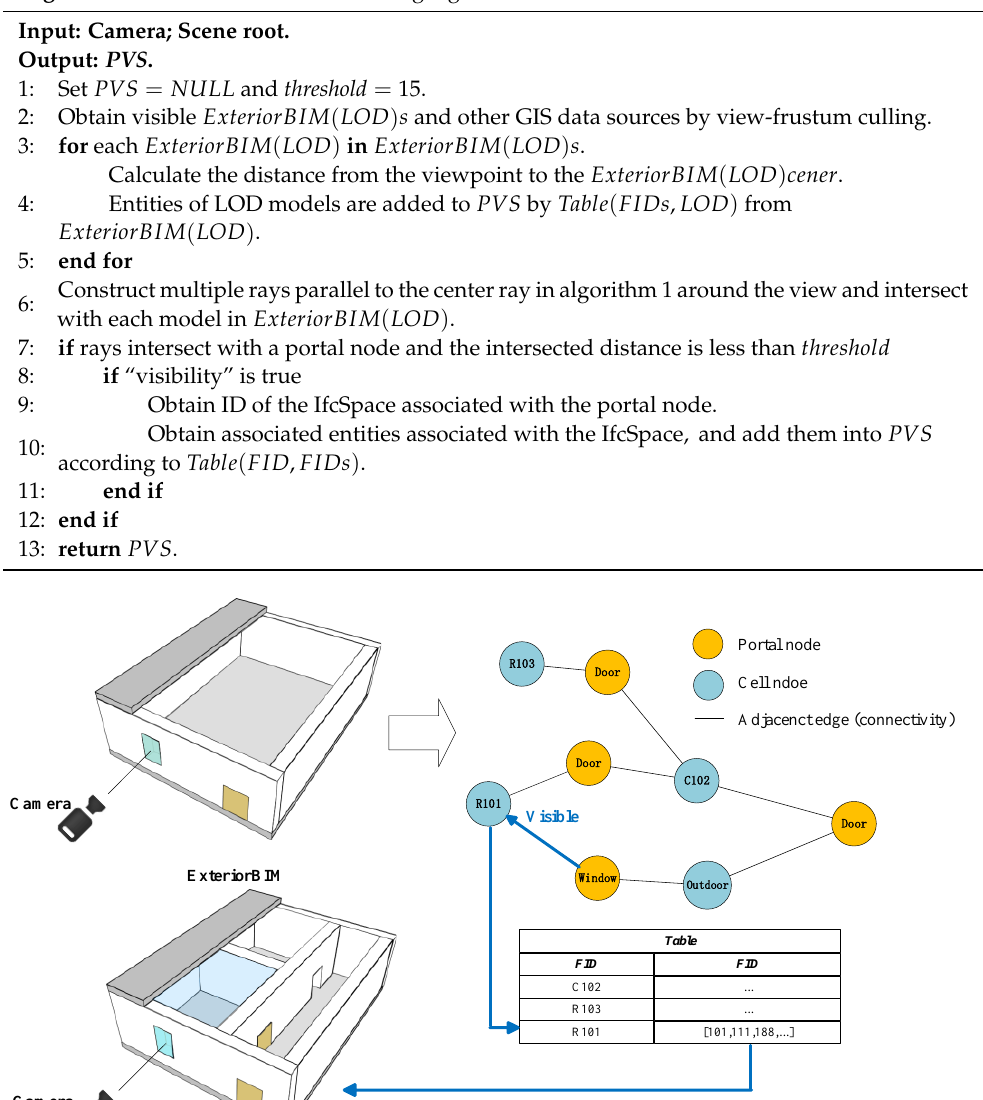
Algorithm 3 . Semantic-based scheduling algorithm for outdoor scenes